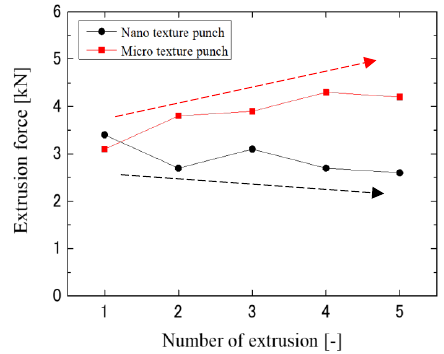
Figure 9. Extrusion force vs. number of extrusions.